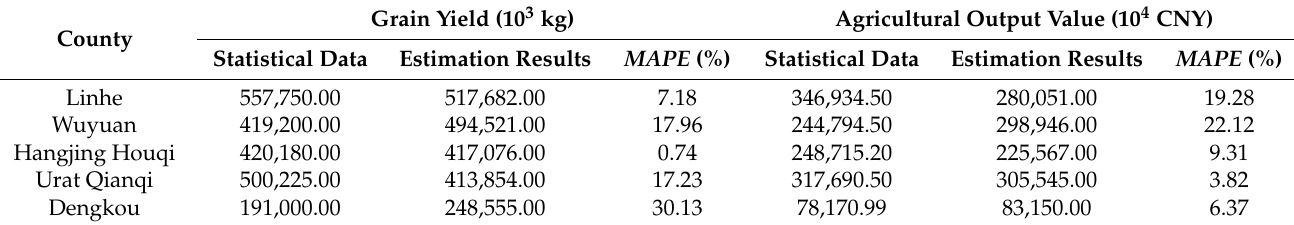
Table 9. Accuracy verification results of each county.